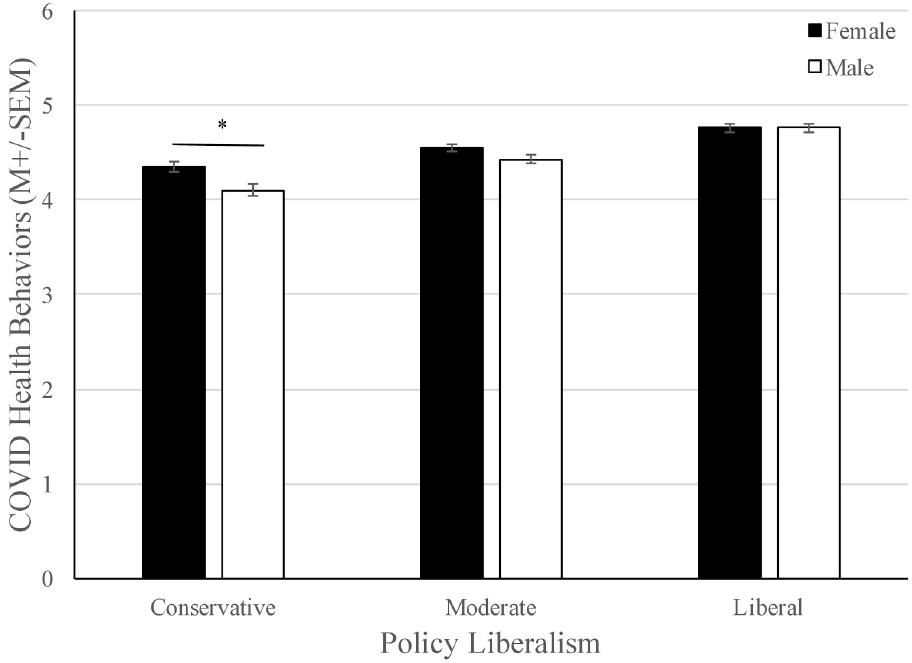
Fig 1. The interaction between policy liberalism and gender on adherence to COVID-19 specific health behaviors. Males and females high in policy liberalism did not differ in their adherence to COVID-19 specific health behaviors; however, males who have a conservative policy stance were much less likely to adhere to COVID-19 specific health behaviors, F (1,940) = 8.18, p = .004.